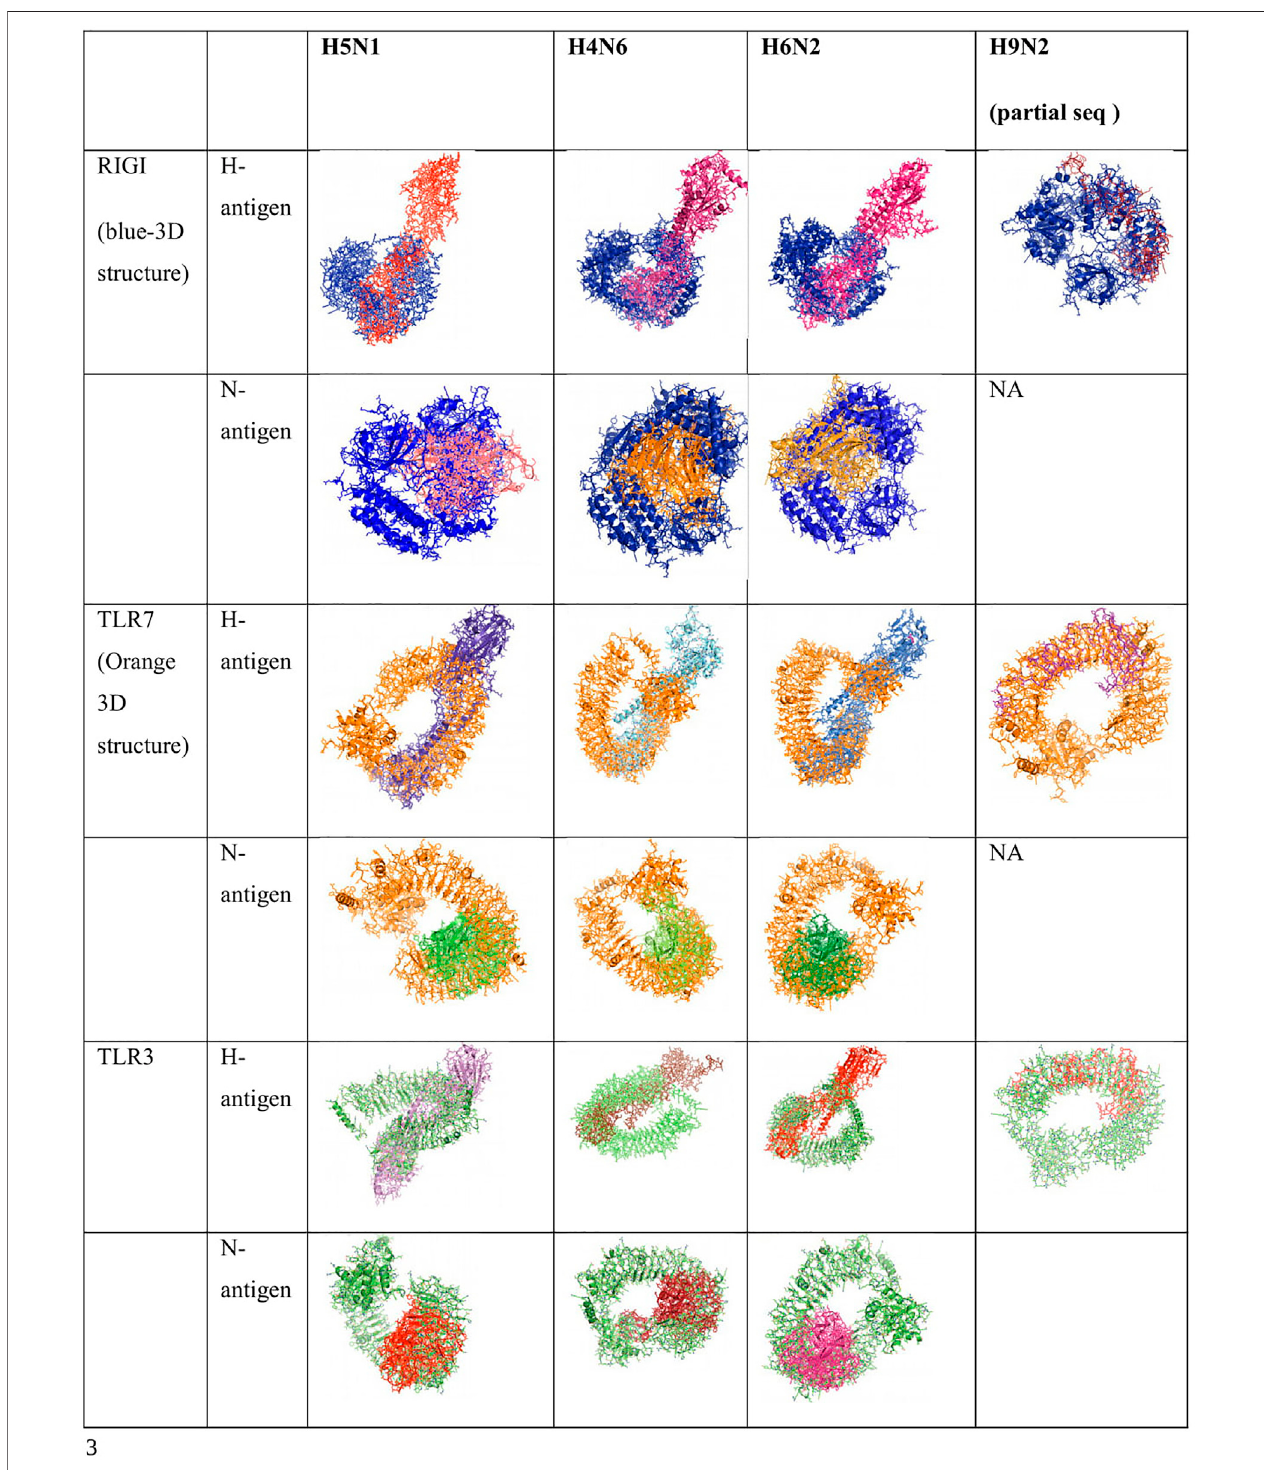
FIGURE 4 | Alignment/binding of identi fi ed immune response molecules with hemagglutinin and neuraminidase for different strains of avian in fl uenza.